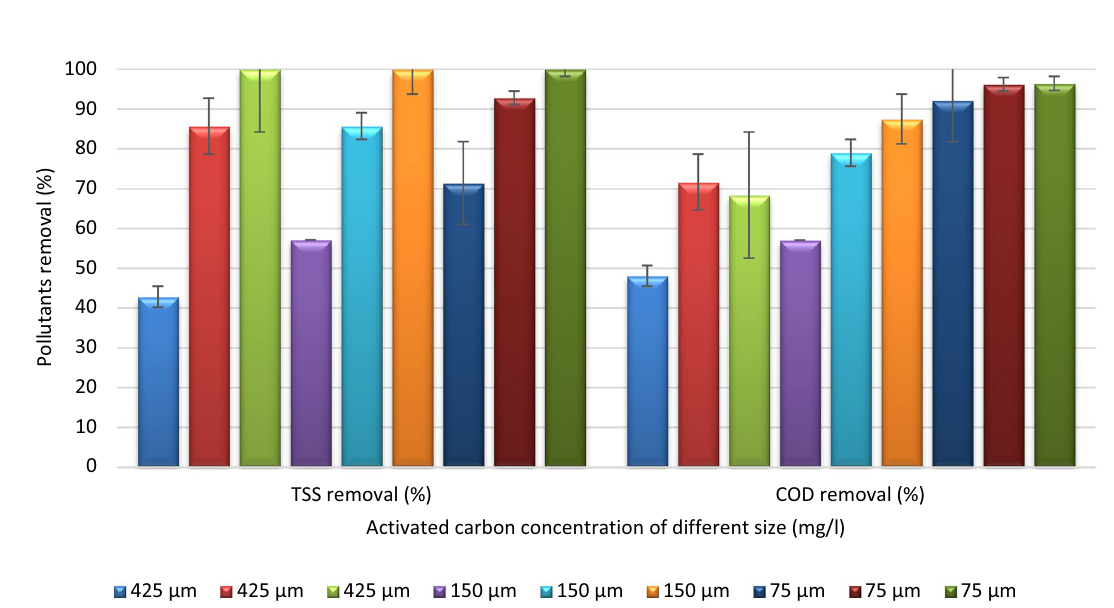
Fig. 8 Effect of banana peels activated carbon concentration and size on removal efficiency of different pollutant